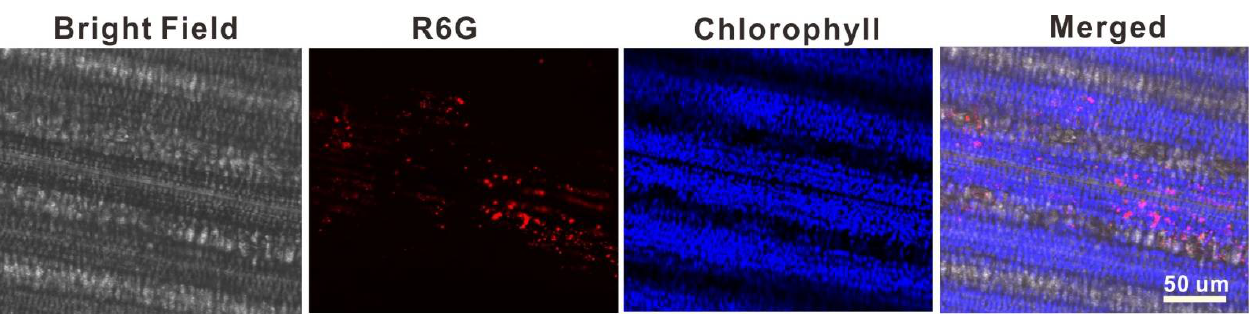
7 of 13 Figure 2. Contact angle of DSPE-EB nanoparticles ( A ) and EB-EC ( B ) on the surface of maize foliage; ( C ) the retention of the DSPE-EB nanoparticles and EB-EC solutions on maize leaves. 3.2.2. Retention and Adhesion Ability Analysis A good retention ability of pesticides can improve their bioavailability. The retention of the DSPE-EB nanoparticles and EB-EC solutions on the maize leaves were measured (refer to Section 2.6 for the experimental procedure). The retention of the DSPE-EB nano-